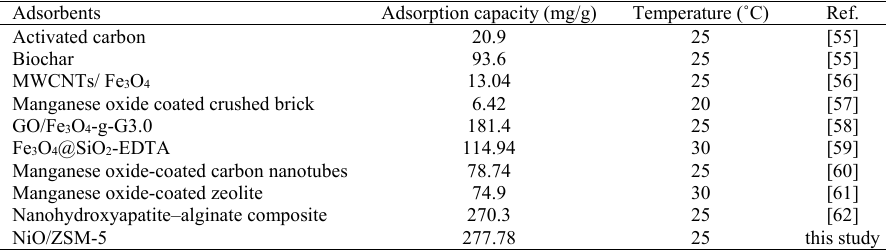
Table 4. Comparison of the lead ion adsorption capacities of the various adsorbent.